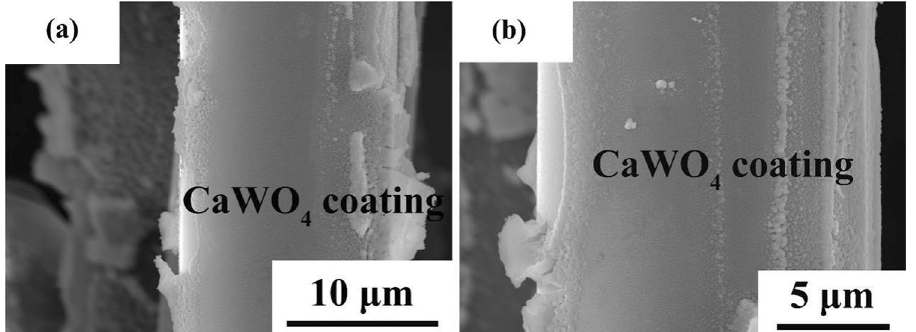
Figure 5. Surface morphology of CaWO 4 coated SiC fiber.